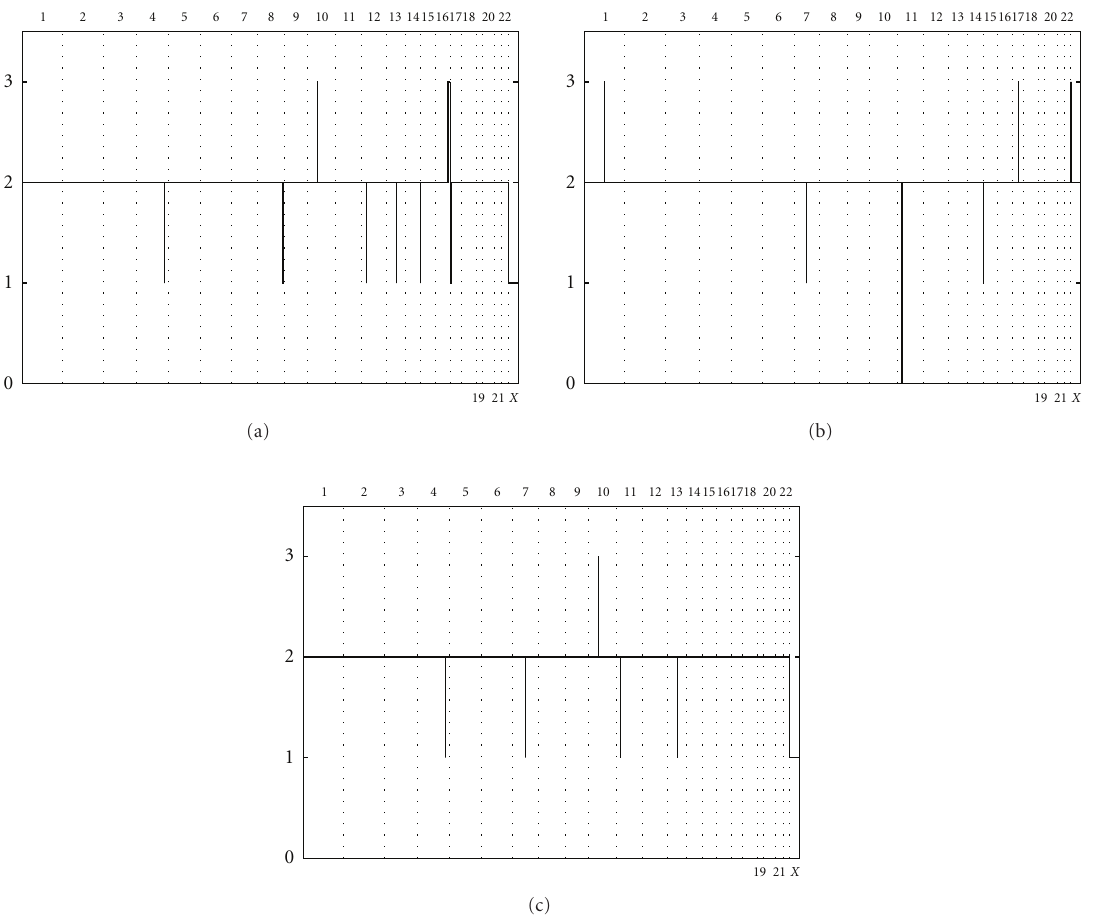
Figure 2: Results of CN analysis for noncancerous cell lines from nuclear family: NA12056 from the father (a), NA12057 from the mother (b), and NA10851 from the son